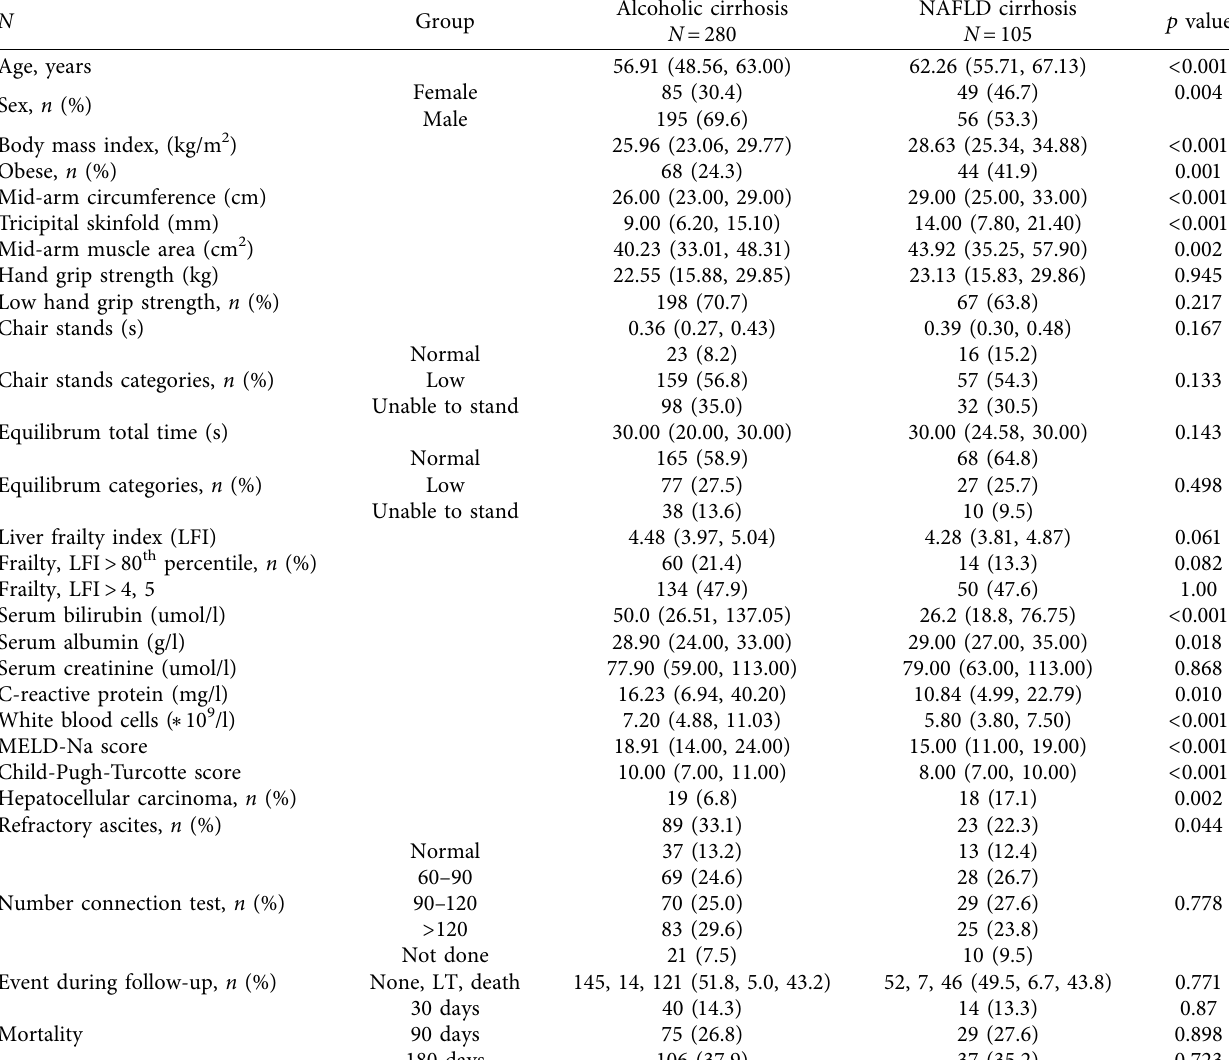
Table 1: Summary statistics and characteristics of the study groups, a comparison of NAFLD cirrhosis and alcoholic cirrhosis